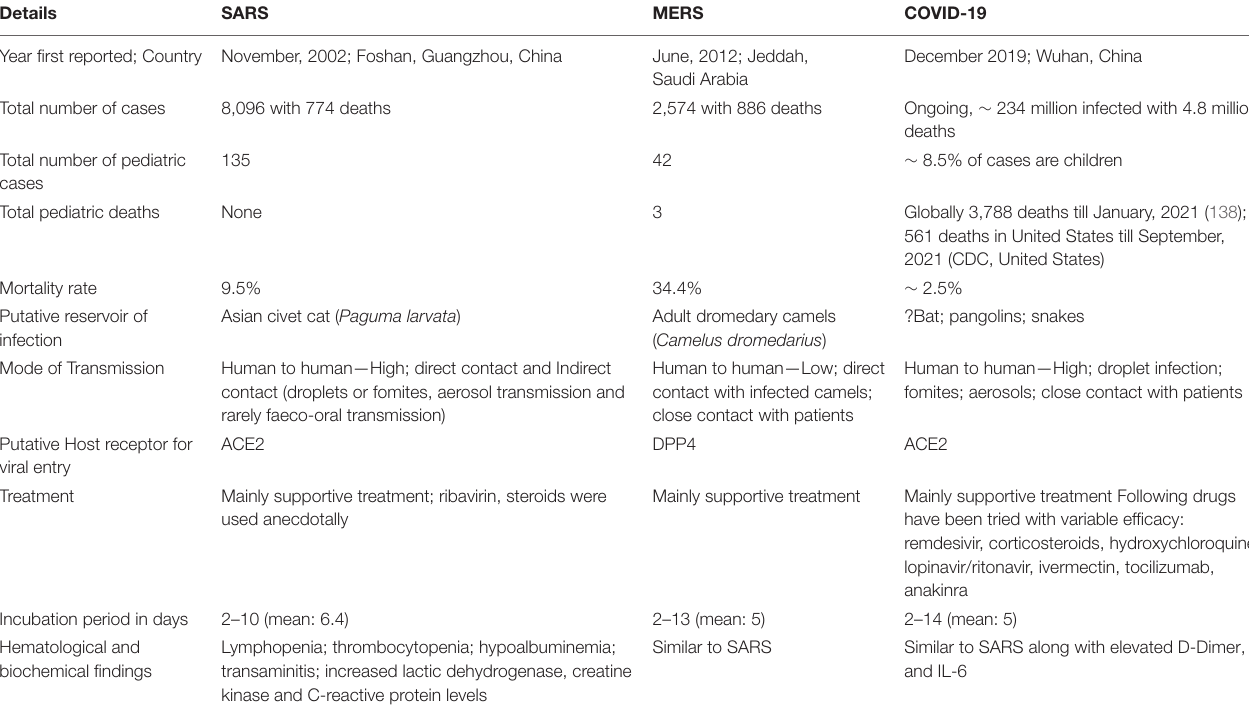
TABLE 1 | Clinical characteristics and epidemiology of SARS, MERS and COVID-19. Details